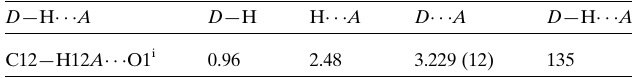
Table 1 Hydrogen-bond geometry (A˚ , (cid:2) ).